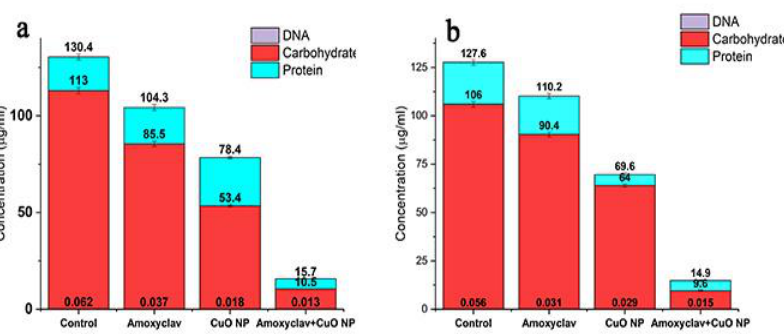
Figure 6. Inhibition of extracellular polymeric substance (EPS) formation by amoxyclav and CuO ( a ) P. mirabilis; and ( b ) S. aureus.